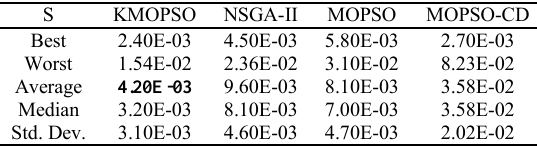
Table 18 . Results of the spacing metric for ZDT4.